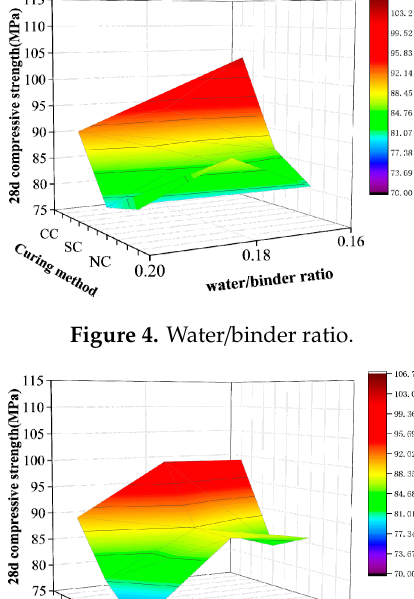
Figure 5. Silica fume content.